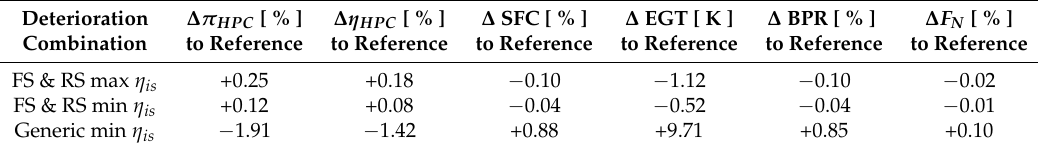
Table 4. Changes in engine performance parameters for the cruise